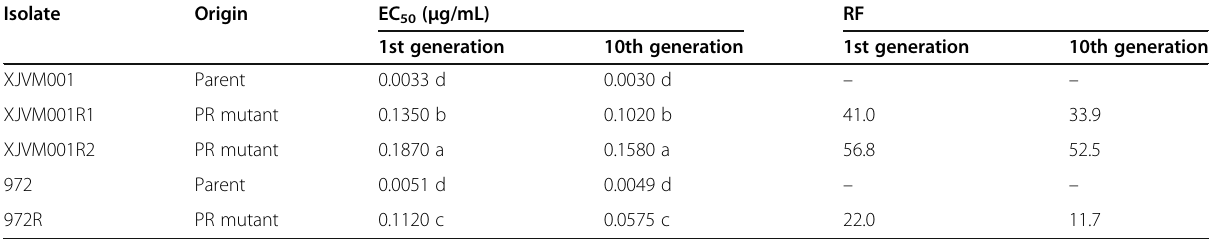
Table 2 Level and stability of pyraclostrobin resistance in PR mutants and their parental isolates of Valsa mali Isolate